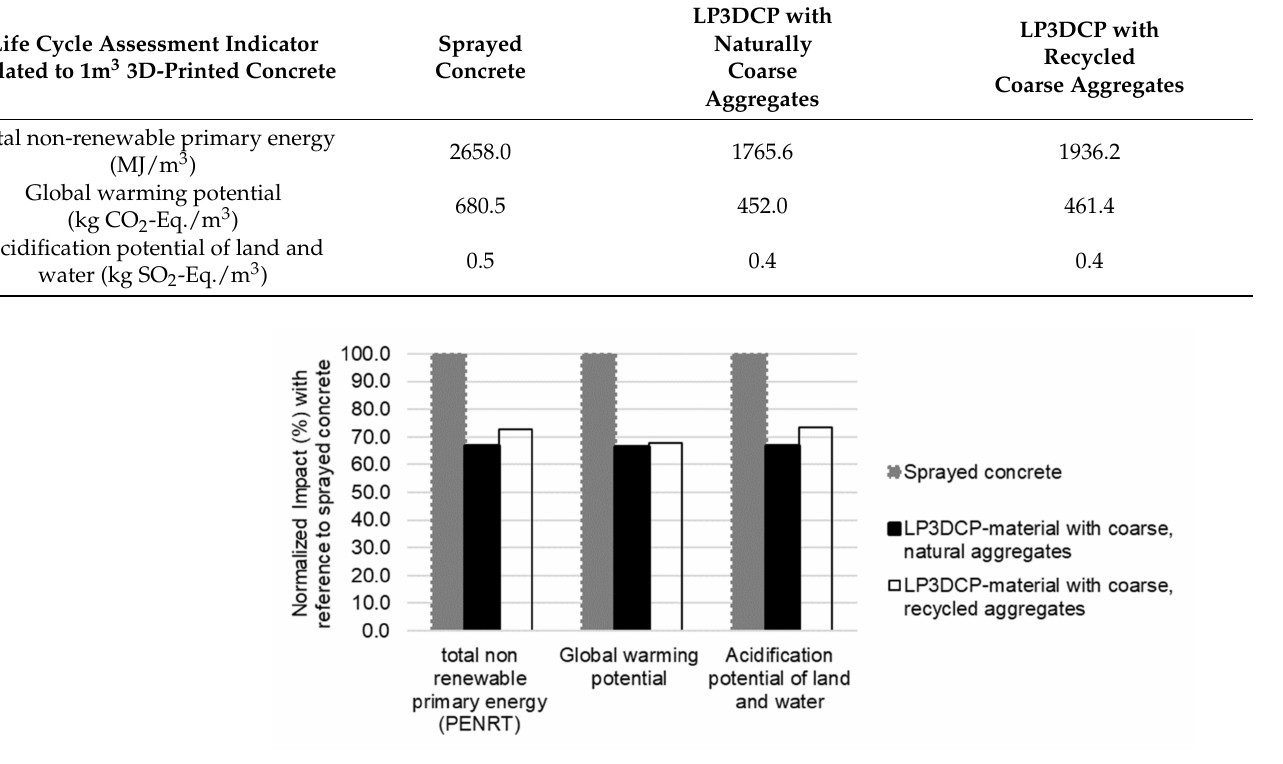
Figure 12. Ecological potential of LP3DCP compared to purely sprayed concrete shown for selected factors of a life cycle